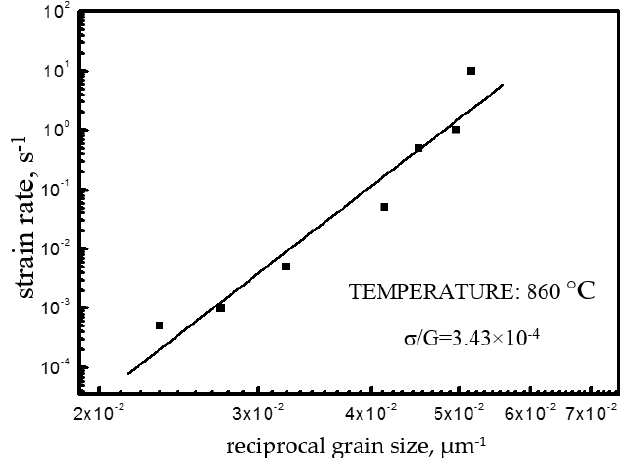
Figure 7. Microstructures of the TC4 alloy deformed at different strain rates (T = 860 °C). ( a ) 5 × 10 −4